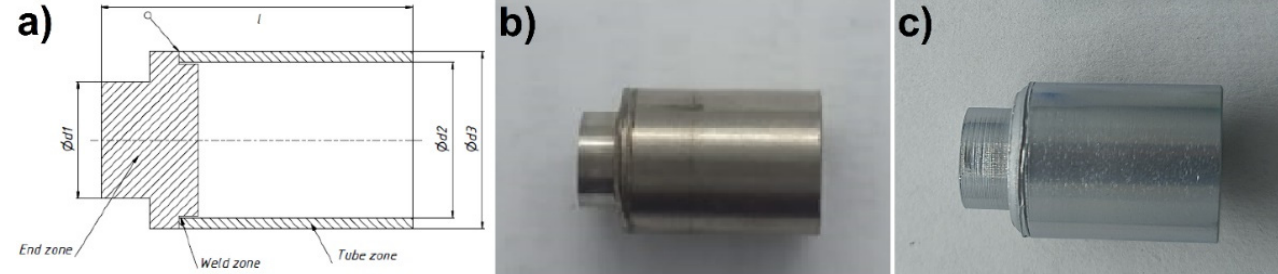
Figure 1. The schematic drawing of an RUW specimen ( a ). Appearance of ( b ) uncoated and ( c ) Cr-coated RUW E110 alloy specimens before hydrogenation tests.